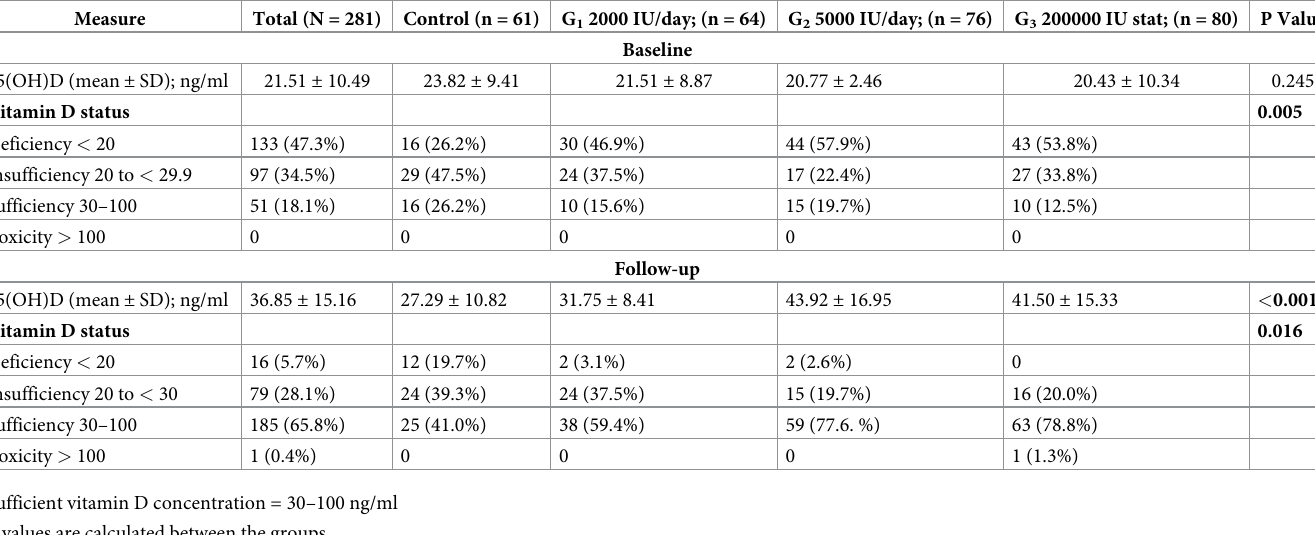
To the best of our knowledge, this is the first study to explore the impact of various vitamin D antenatal supplementation regimens among pregnant women in Pakistan. The key findings of the present study demonstrated the high prevalence of VDD during gestation. Women Table 2. Vitamin D status between the treatment